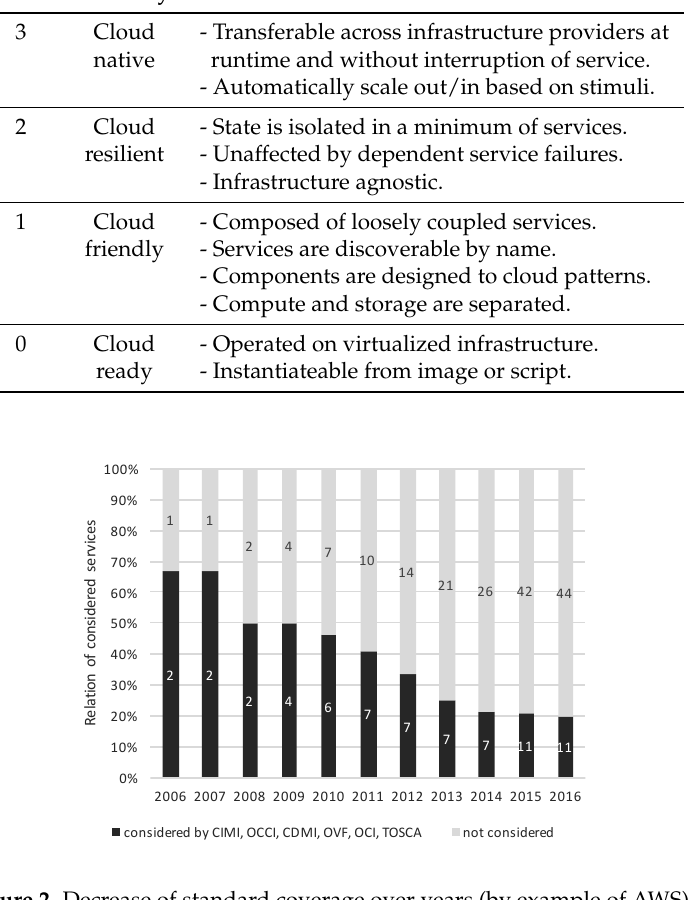
Figure 2. Decrease of standard coverage over years (by example of